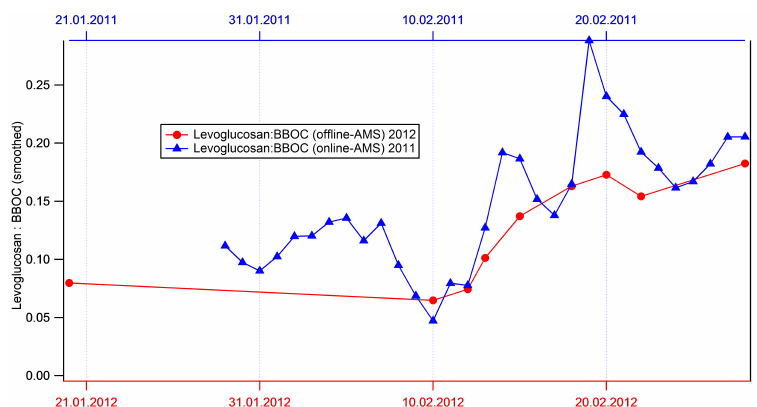
Figure 10. Offline-AMS (February 2012) and online-AMS (February 2011) smoothed time-dependent levoglucosan:BBOC ratios. We note that the levoglucosan:BBOC comparison should not be considered on a day-to-day basis, where the levoglucosan:BBOC ratio in the 2 different years can be coincidentally equal or different, but rather on a monthly timescale where, as discussed in the paper, we observed a statistically significant ( p = 0 . 05) evolution of the levoglucosan:BBOC ratio which is similarly captured by the two models.